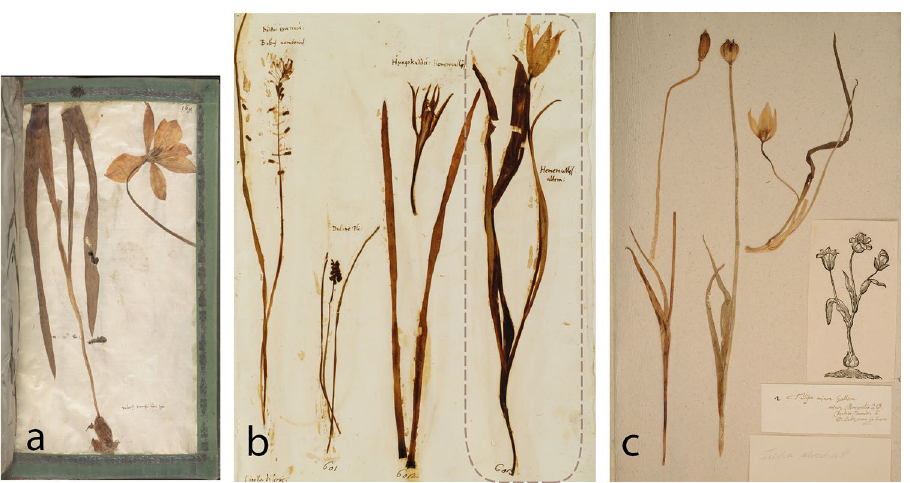
Figure 5. Specimens of Tulipa sylvestris collected by sixteenth-century botanists. Leonhard Rauwolf, northern Italy, 1563. Naturalis Biodiversity Center ( a ). Andrea Cesalpino, Pisa, 1563. Museo di Storia